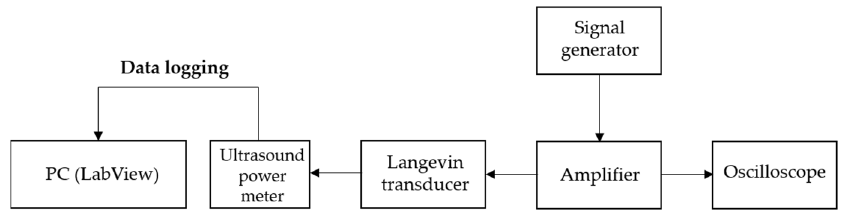
Figure 5. Layout of acoustic power measurement system.